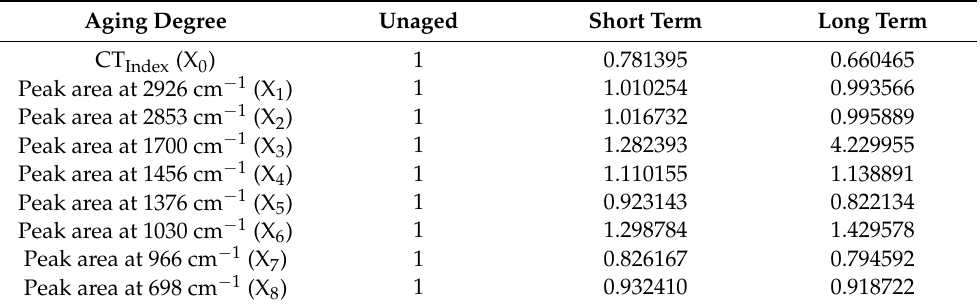
Table 7. Normalized index of the grey correlation data between CT Index and different peak ar- eas